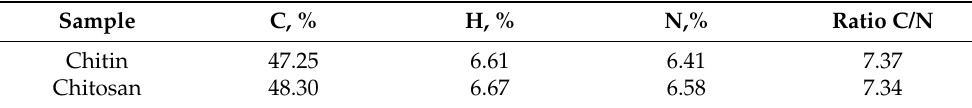
Table 1. Elementary analysis of chitin and chitosan samples.